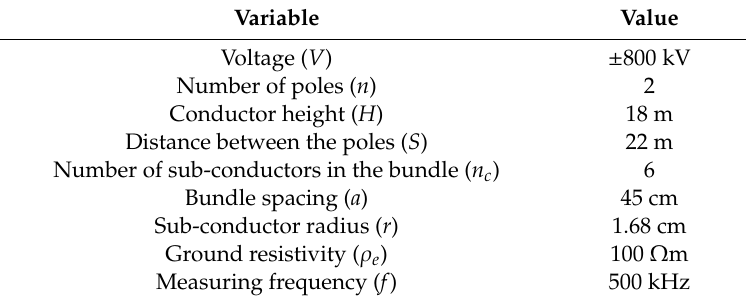
Table 1. Data of the high voltage direct current (HVDC) test line considered in the